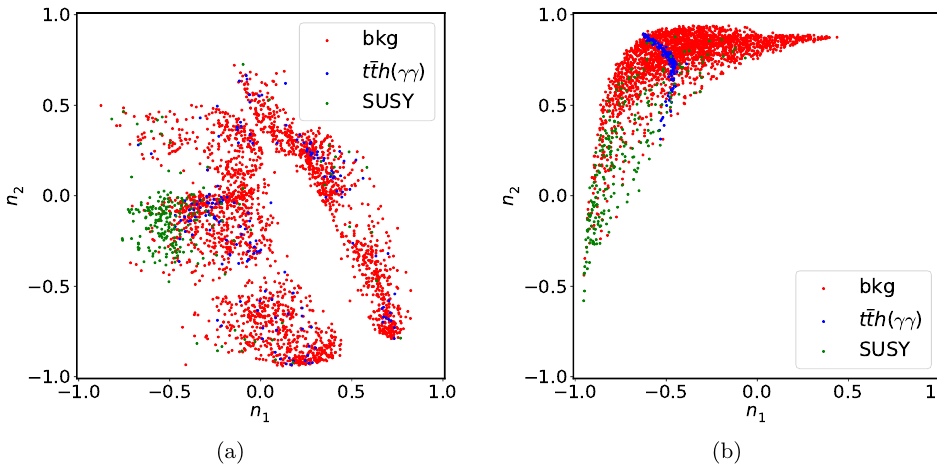
¯˜ t signal (green points), and background